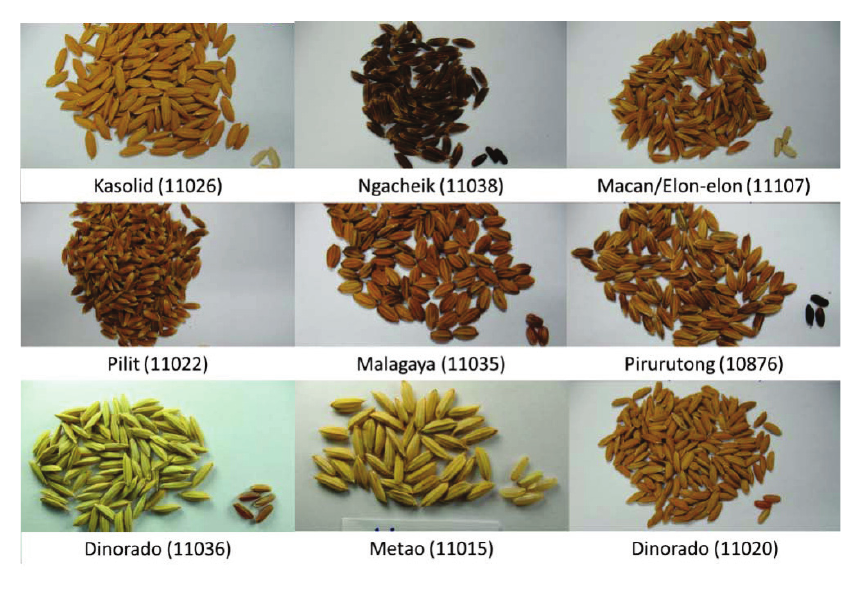
Figure 1. Diversity in grain color and caryopsis pericarp color of the different traditional rice varieties screened. Numbers in parenthesis are the collection numbers of the rice